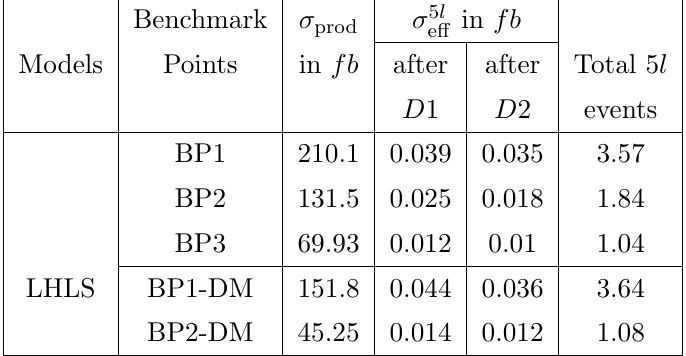
for the BPs de(cid:12)ned in table 5 e(cid:11)